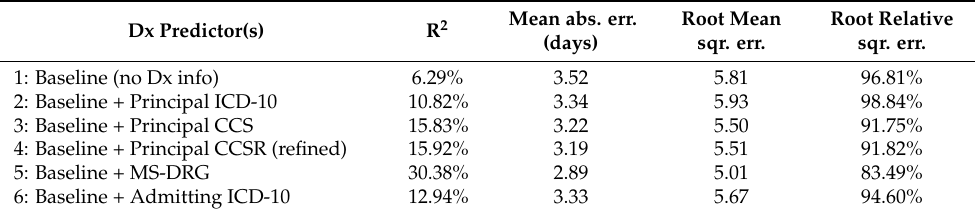
Table 4. Regression Analysis to compare the predictive power of Dx code systems for the outcome of inpatient LOS. Dx Predictor(s) R 2